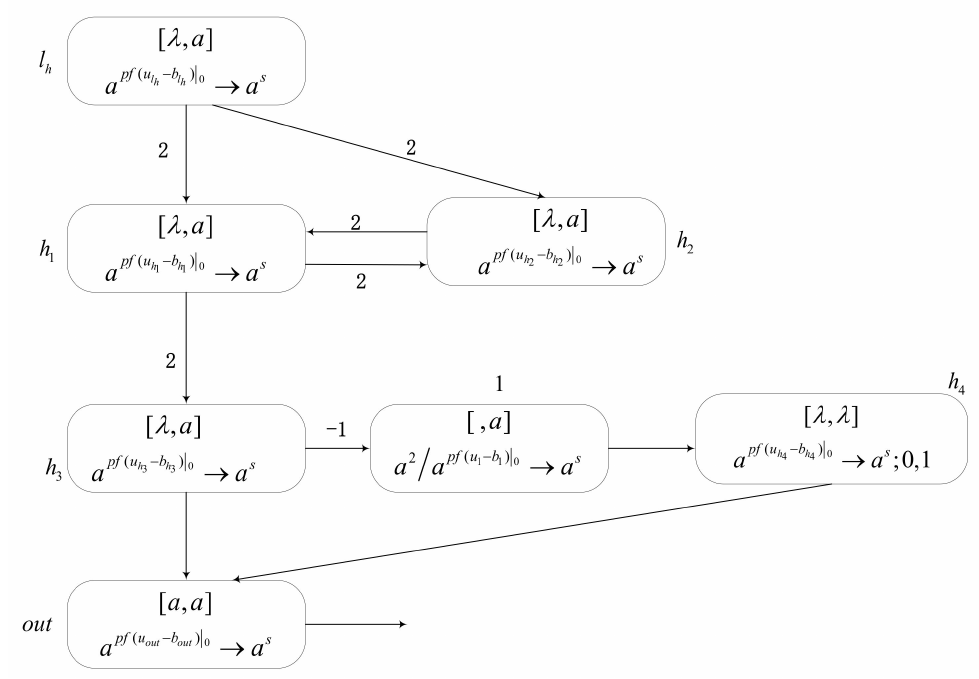
Figure 7. Module FIN. Its function is to output the computation